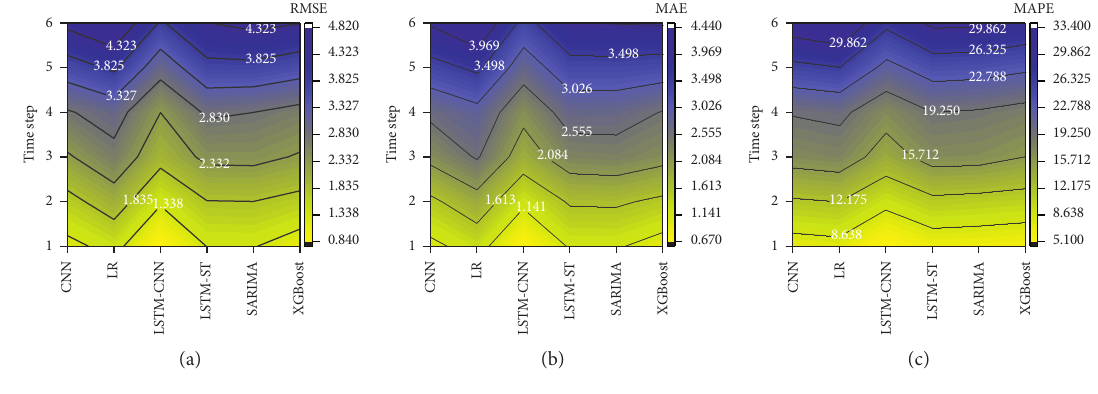
Figure 10: Error results of different time steps. Table 3: RMSE comparison of multistep prediction.